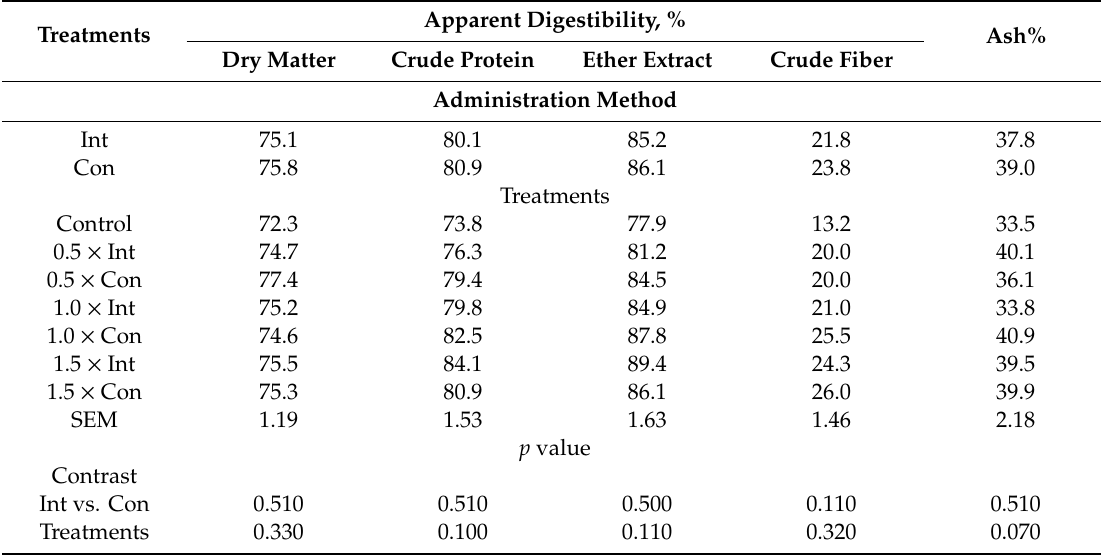
Table 4. E ff ects of multienzymes supplemented continuously or intermittently on apparent nutrient digestibility (%) during 36–40 days of age of Arbor Acres broiler chicks.